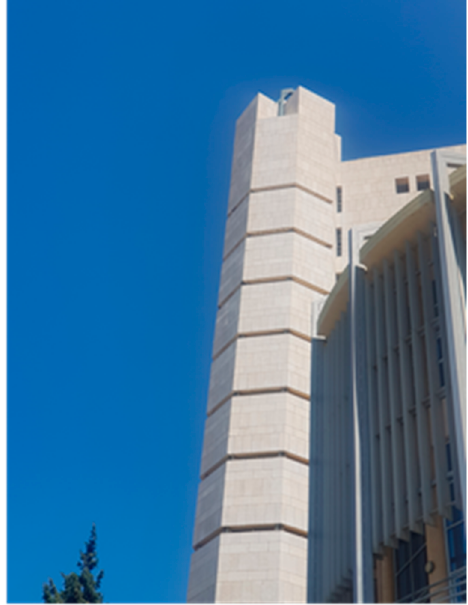
Figure 10. Exterior envelope (Maintenance Indicator = 2.5).